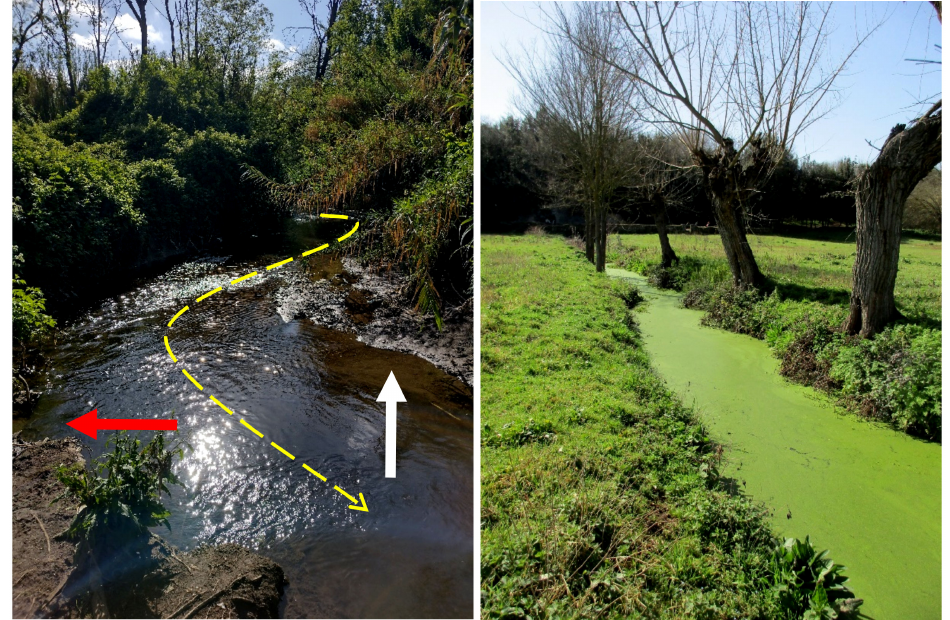
Figure 4. Meander of river Almone (yellow line: flow direction): deposition of material on the inside bank of the bend (white arrow) and erosion of the outside bank (red arrow) (left side photo); secondary channel in Caffarella valley (right side photo).